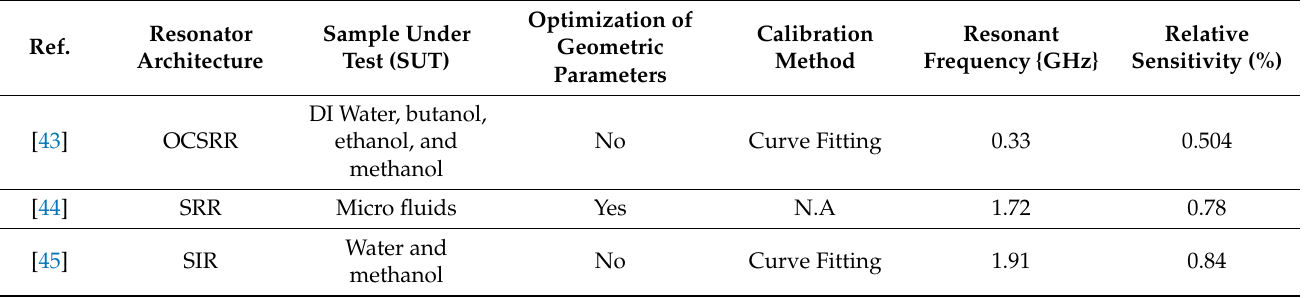
Table 4. Comparative analysis of contemporary sensors based on optimization, calibration method, and relative sensitivity.